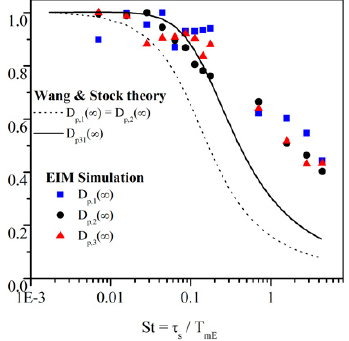
Figure 10. Particle dispersion coefficient (g ≠ 0).